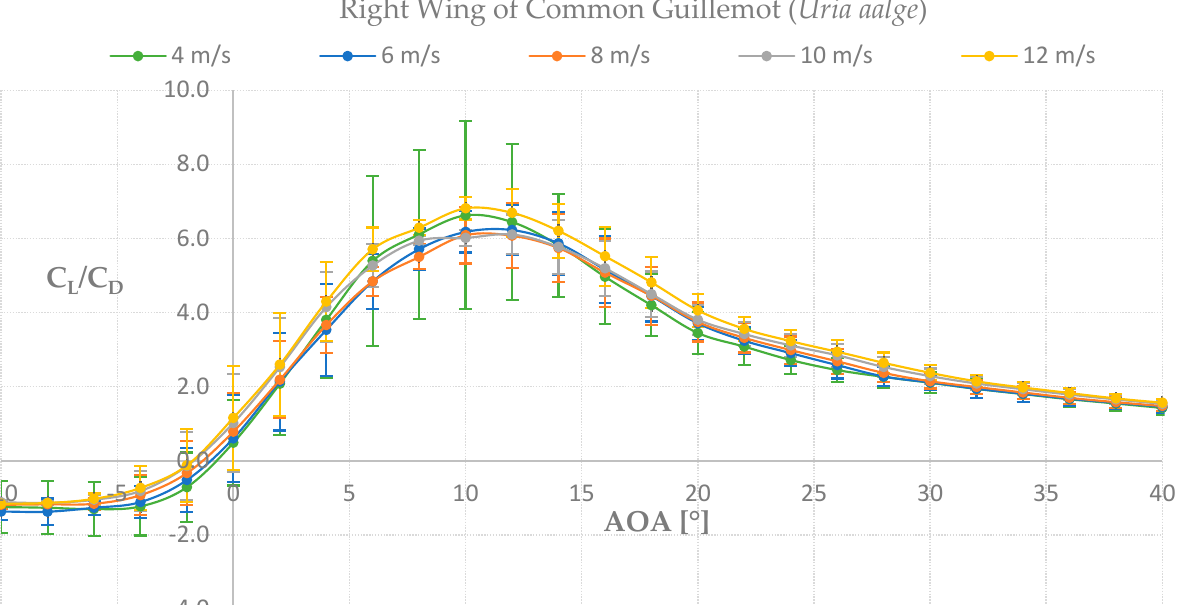
Figure 12. Force measurements of lift − to − drag coefficient against angle of attack for the right wing.